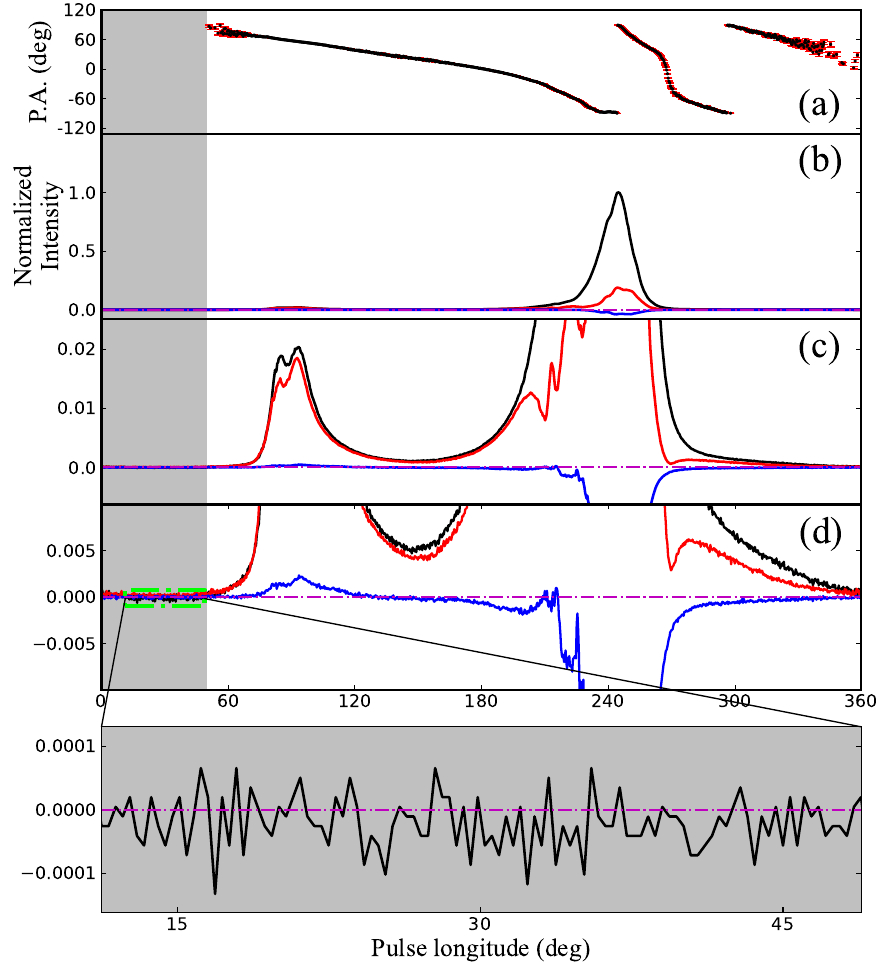
Figure 1. The polarized profile of PSR B0950+08. Panel ( a ) is the linear polarization position angle. Panel ( b ) is the polarized profile (the black, red and blue solid lines represent the total intensity, the linearly polarized intensity and the circularly polarized intensity, respectively). Panel ( c ) indicate × 100 times the extent for panel ( b ). The bottom panel shows the extent of the off-pulse window of the average pulse profile (the green square region of panel ( d